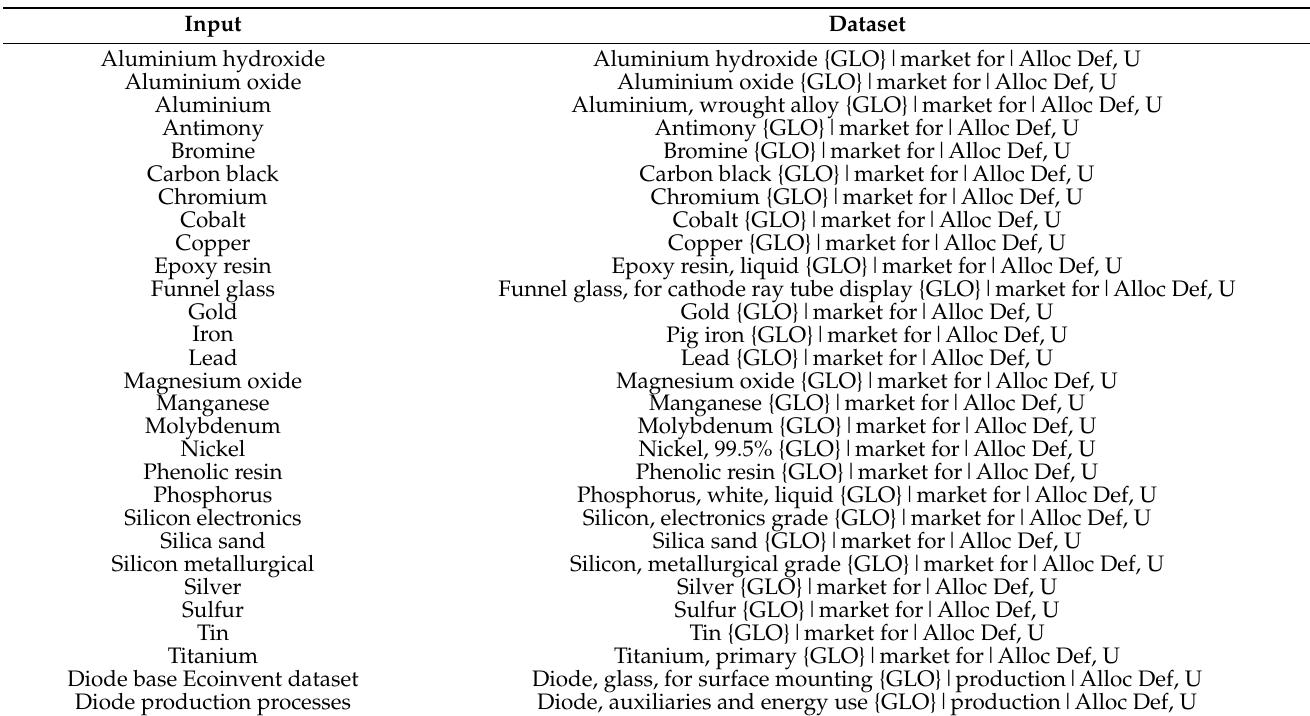
Table 2. EcoInvent dataset selection for the Diode